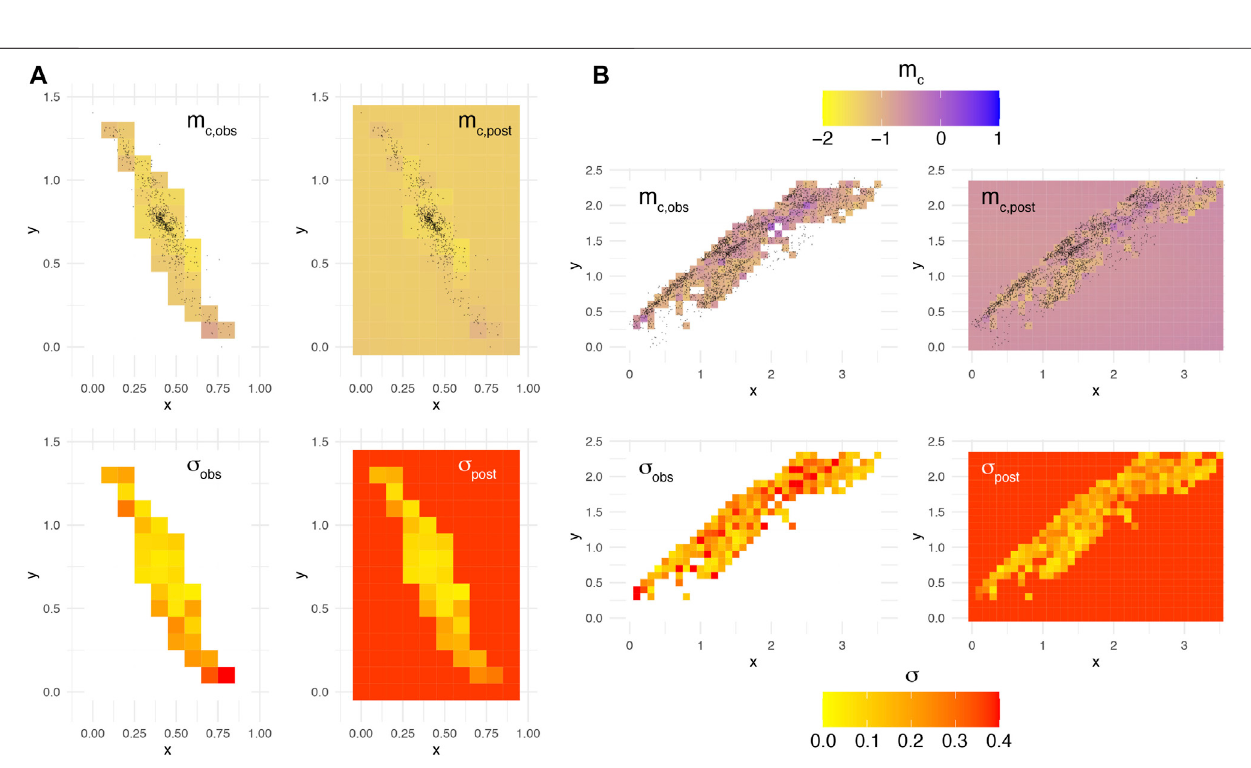
Frontiers in Earth Science |